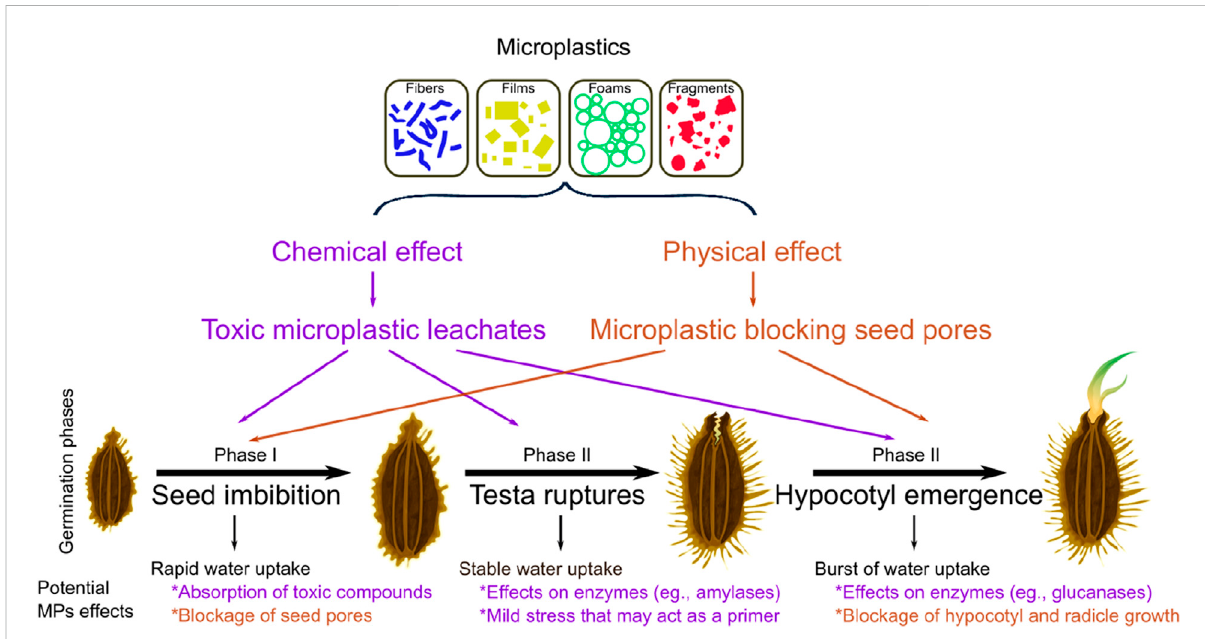
FIGURE 4 Potential effects of microplastics (MPs) on the different phases of seed germination. Microplastics of different shapes may affect seed germination via toxicmicroplasticleachates(chemicaleffects)and/or via blockageofseedpores(physicaleffects).PhaseI(seedimbibition)wouldbe affected due to the absorption of toxic chemical compounds, or due to the blockage of seed pores by MPs. Phase II (testa ruptures) can be affected by the negative effect of MPs leachates on enzymes key for seed germination. In this phase, the mild stress caused by MPs may act to